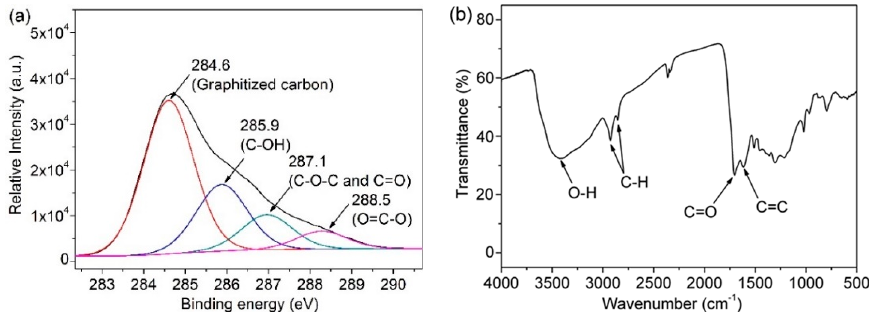
Figure 3. ( a ) X-ray photoelectron spectrometer (XPS) spectrum of the C1s region of wheat-derived carbonaceous particles. ( b ) Fourier transform infrared spectroscopy (FTIR) spectrum of the particles prepared from wheat.